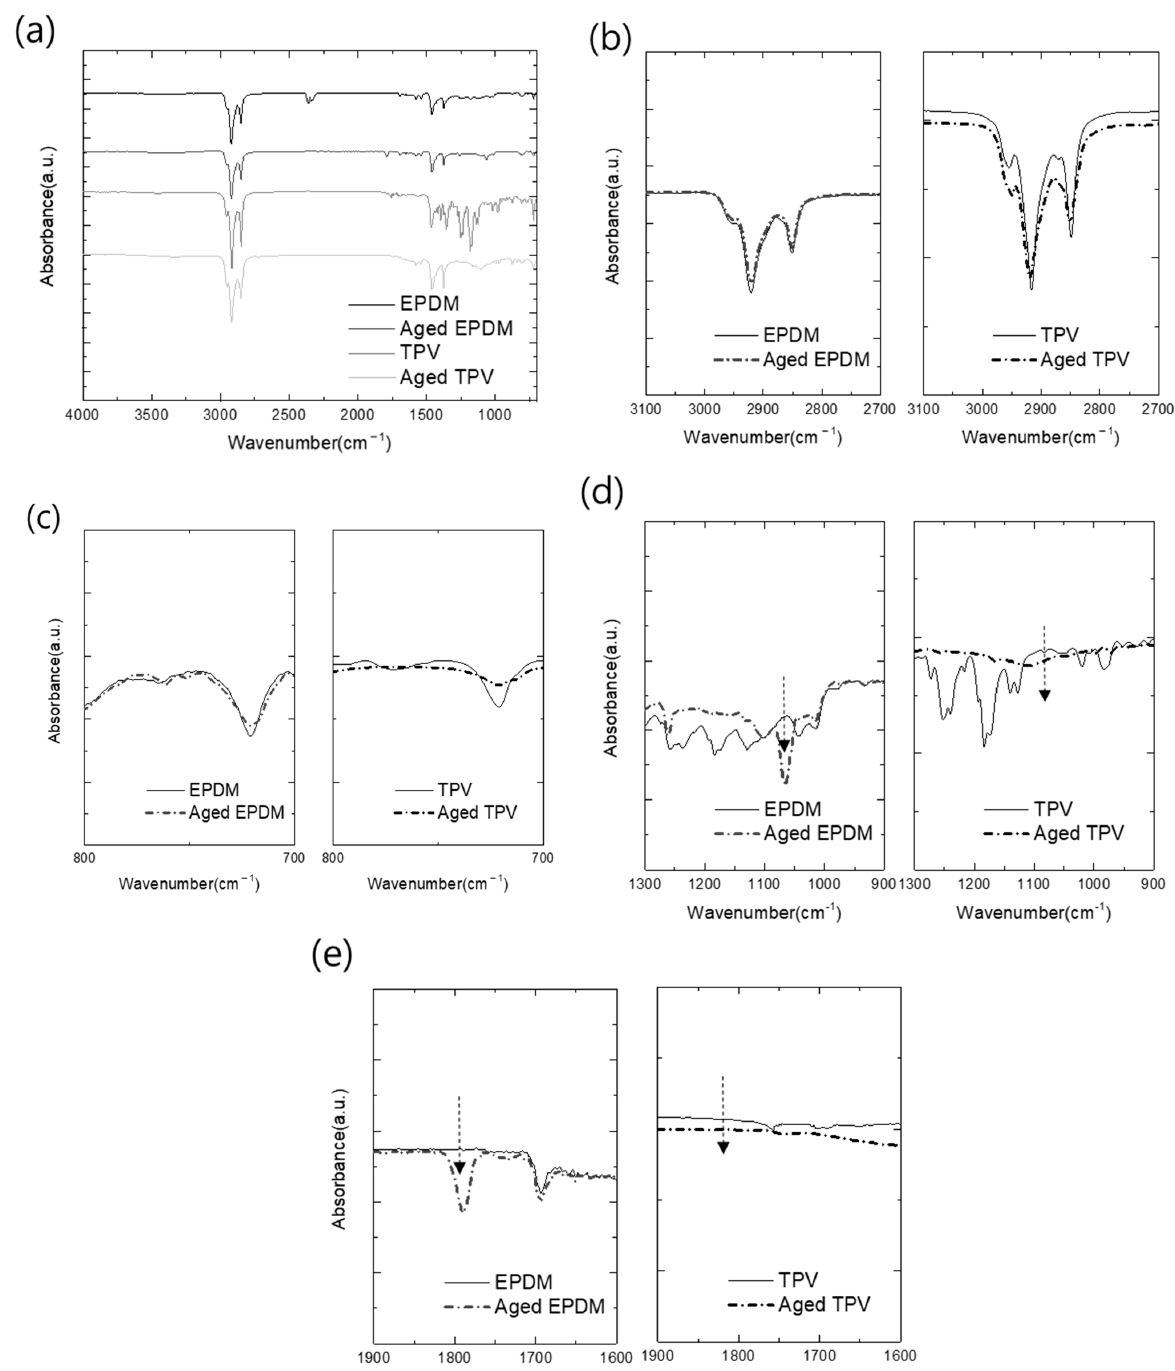
Figure 4. Comparison of FTIR spectra of pristine and thermal oxidized EPDM: ( a ) full-range scan results; ( b , c ) peaks assigned to CH 2 stretching and vibration; ( d , e ) peaks assigned to carbonyl stretching and vibration.